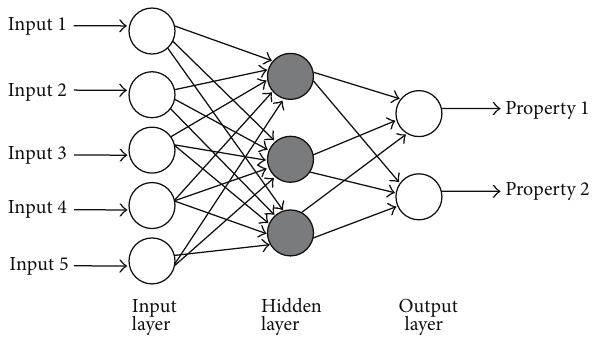
Figure 1: Schematic drawing of multilayer perceptron neural networks